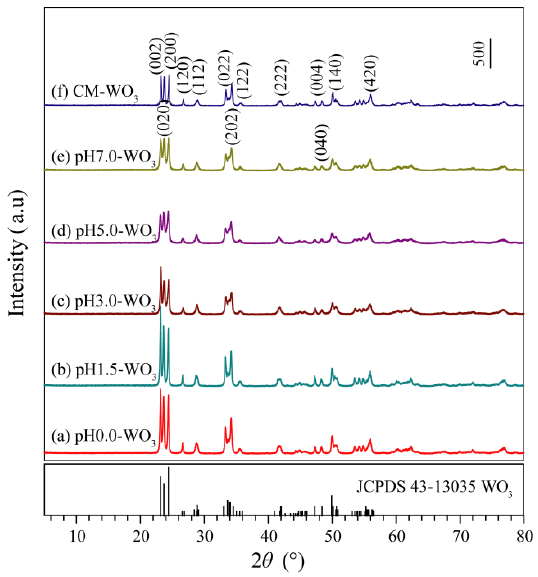
3 and pH7.0-WO 3 for methylene blue solution.